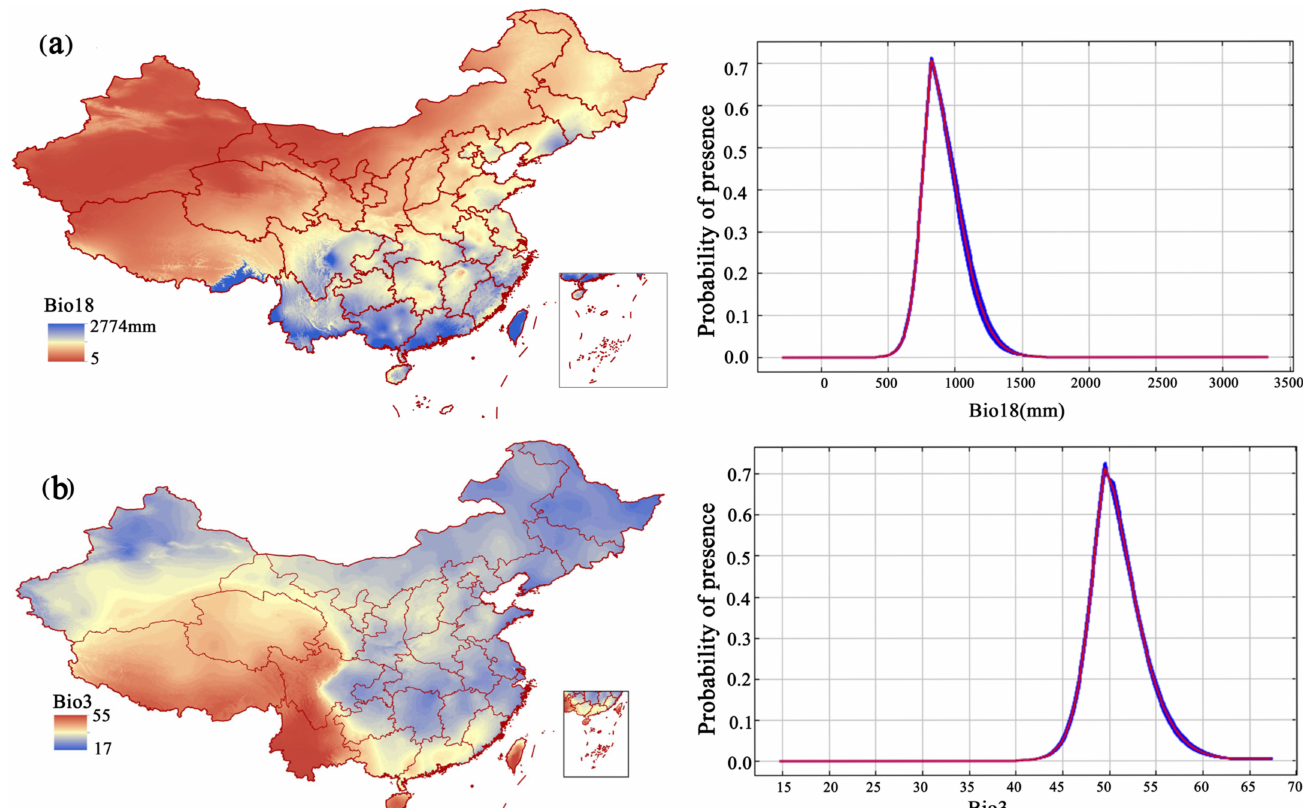
Figure 5. Response curves of the major environmental factors affecting F. strictus ( a , b